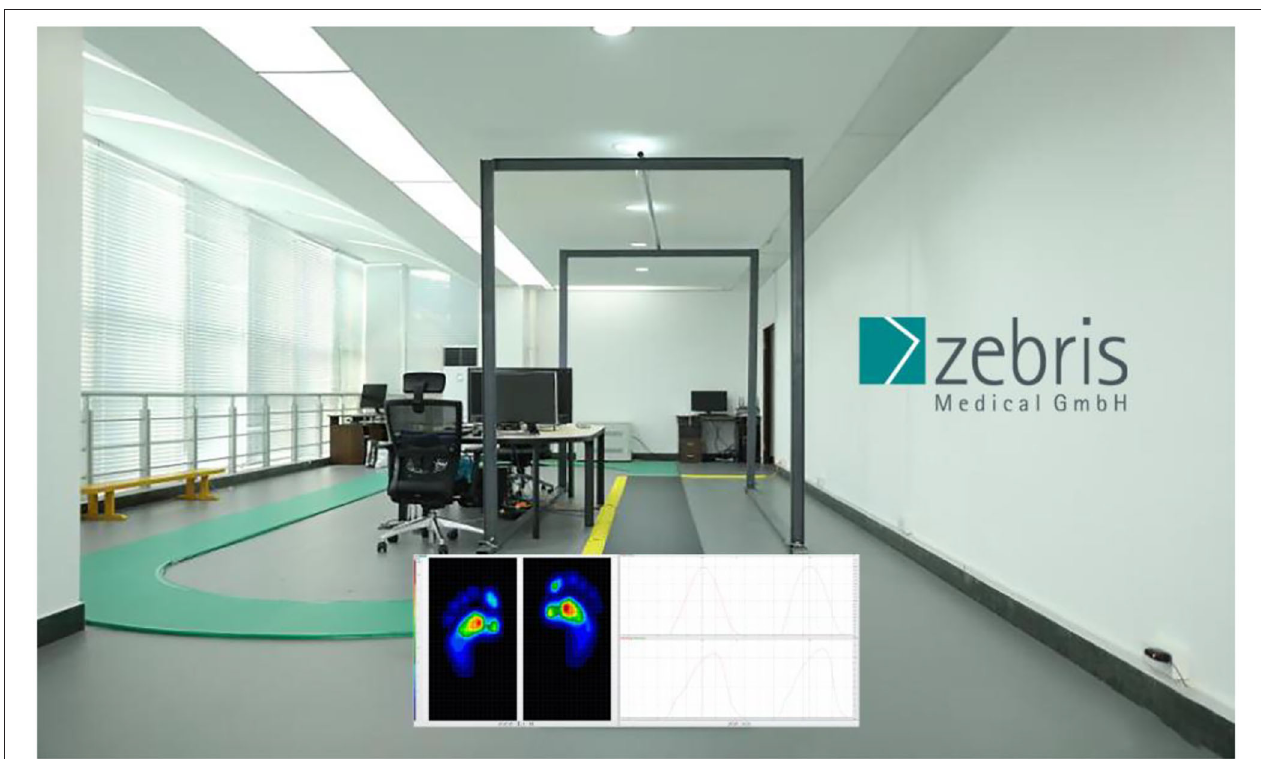
FIGURE 2 | A Zebris FDM plantar pressure measurement system.